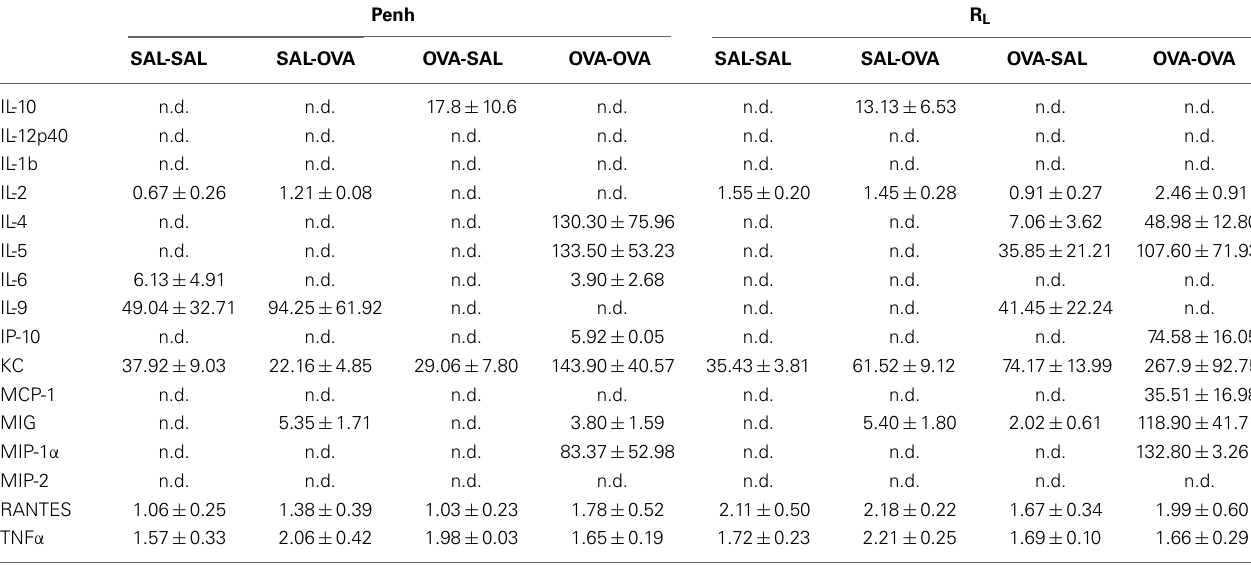
Table 5 | Chemokine and cytokine concentration in broncho-alveolar lavage fluid in the mild airway inflammation model. Penh